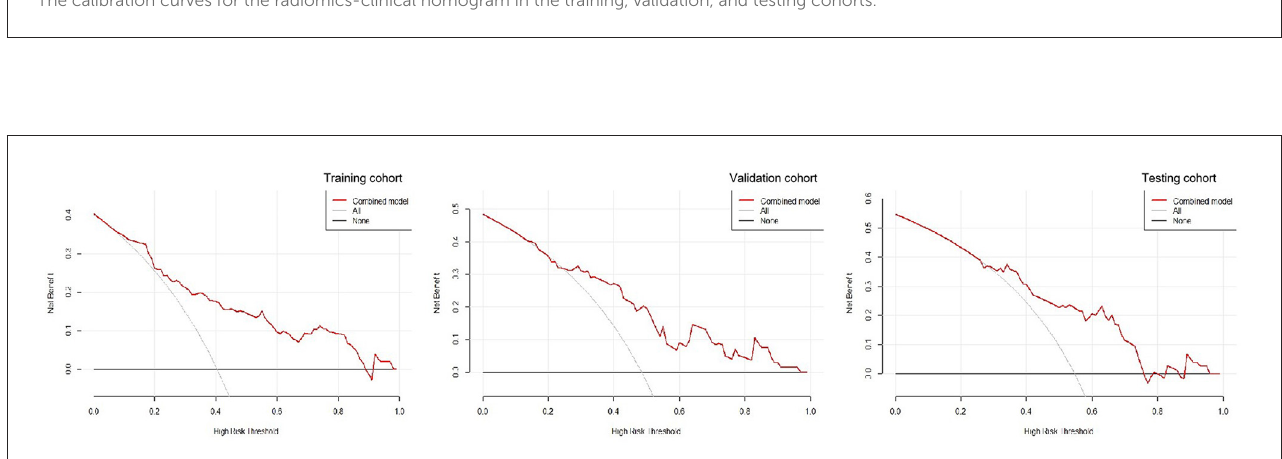
FIGURE6 The decision curves for the radiomics-clinical nomogram in the training, validation, and testing